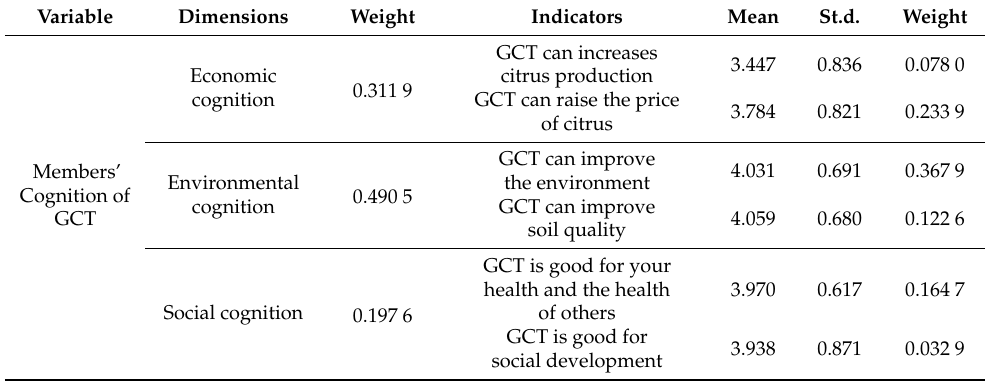
Table 2. Weighted results of green prevention and control cognition.